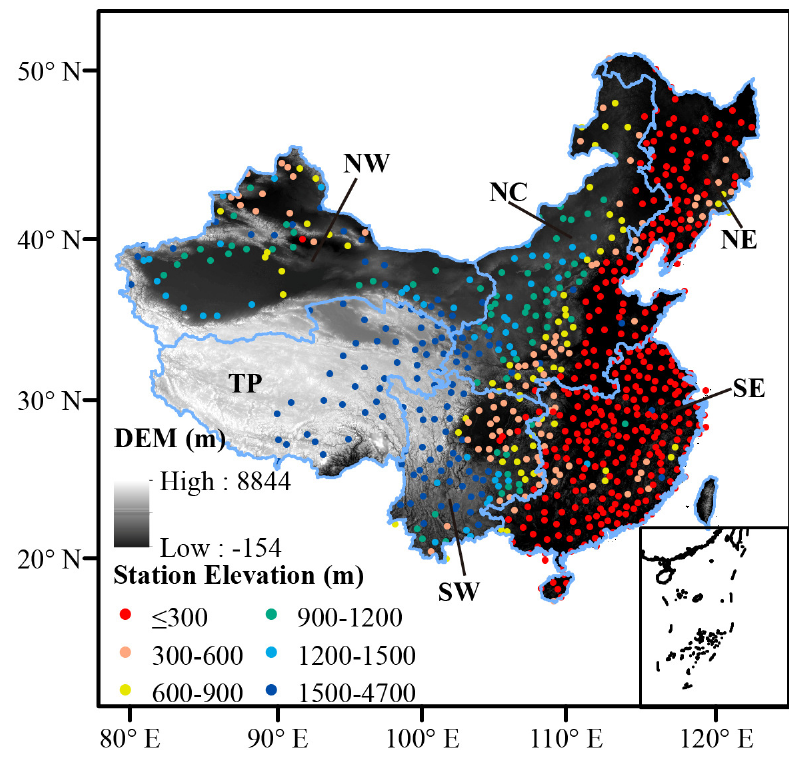
Figure 1. Regions, elevations, and locations of stations in China. The boundaries with blue are the six regions of China, where NE represents the region of northeastern China, NC represents the region of northern China, NW represents the region of northwestern China, SE represents the region of southeastern China, SW represents the region of southwestern China, and TP represents the region of the Tibetan Plateau; the sites are the locations and elevations of the China Meteorological Administration (CMA) stations used in our study.